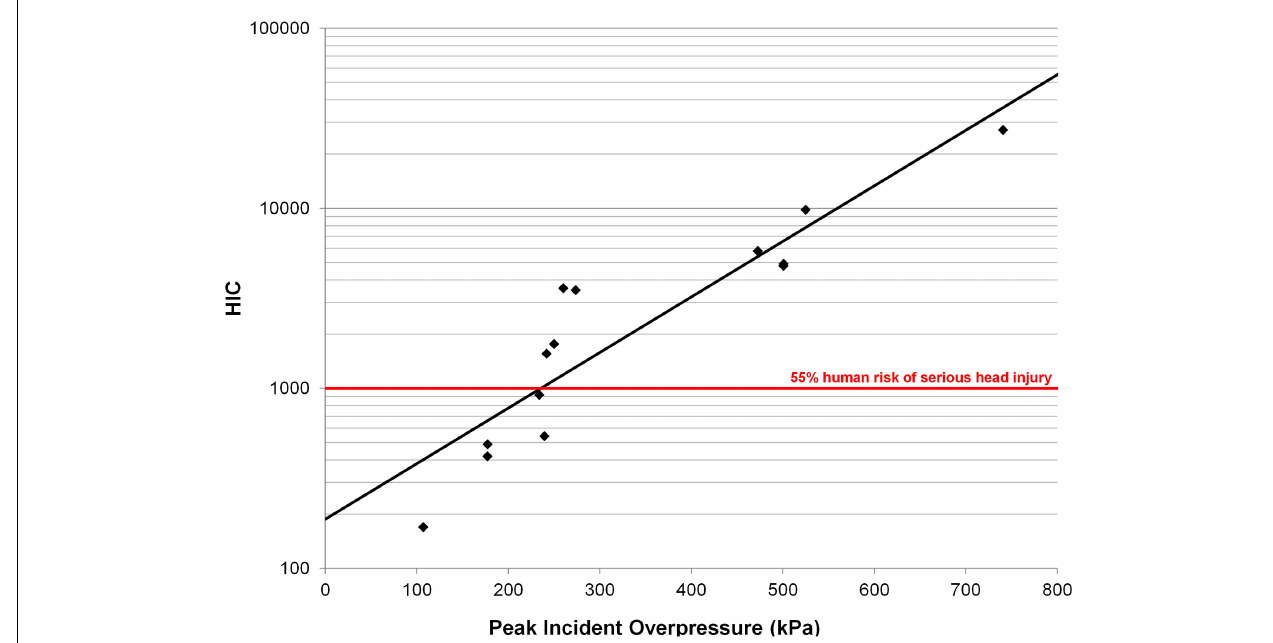
FIGURE 12 | Log-linear model for HIC vs. peak incident overpressure with an R 2 = 0.97 and p < 0.0001.